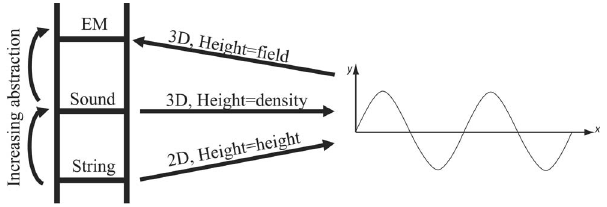
FIG. 6. Scaffolding analogies of increasing abstraction.